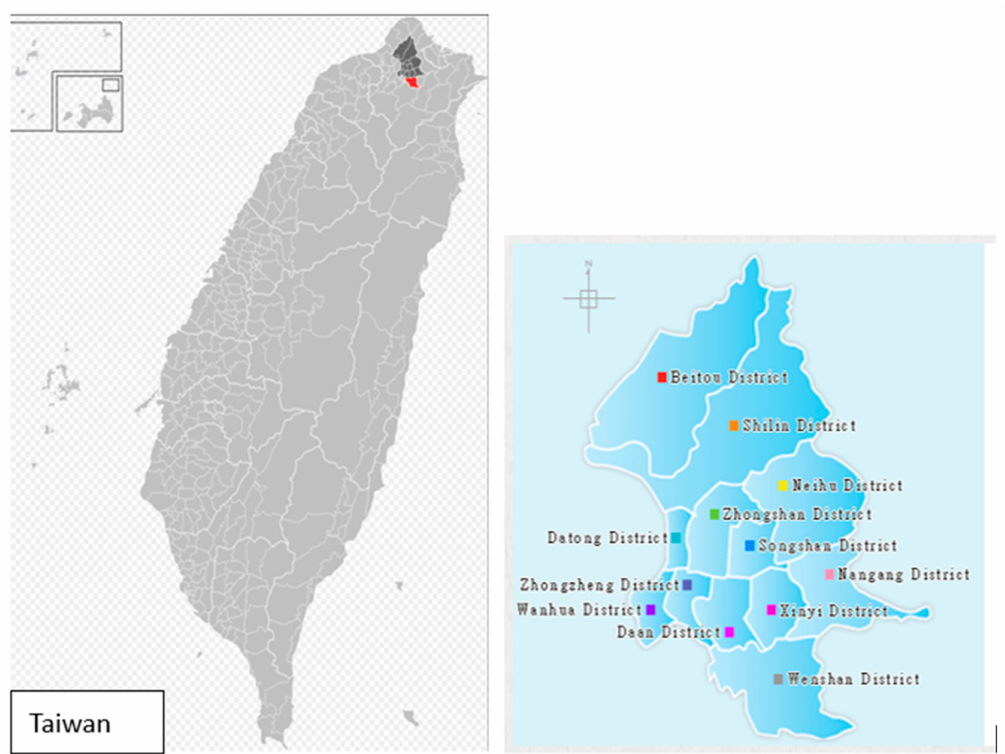
Figure 1. The Wenshan District (red color), located at the border of Taipei City and near the central mountain range (reference from Google